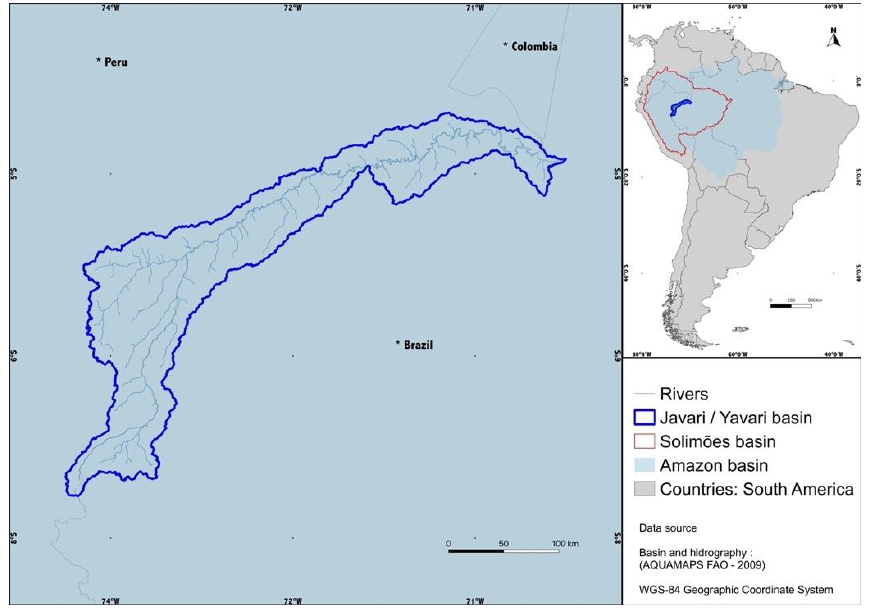
Figure 3 . Location of the Javari/Yavarí River Basin . Figure 3. Location of the Javari/Yavar í River